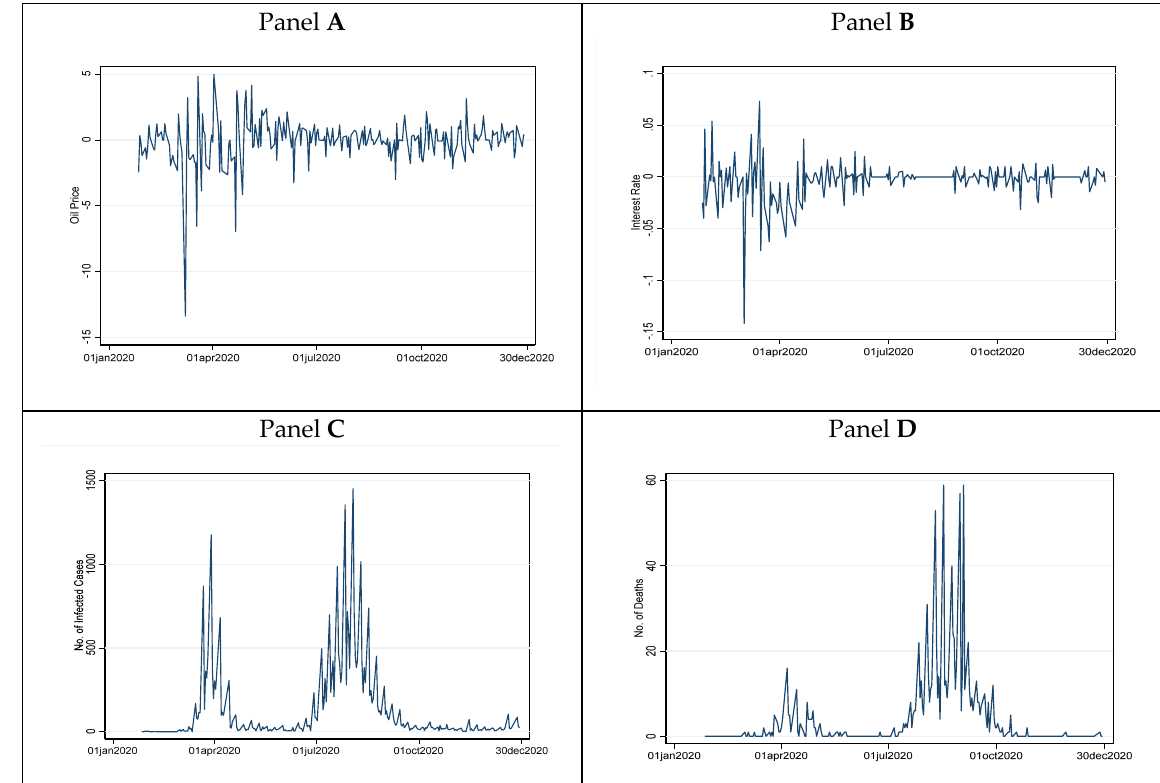
Figure 2. Panel ( A ) shows the first difference of Oil Price, Panel ( B ) depicts the first difference of Interest rates, Panel ( C ) presents the first difference of the number of confirmed cases from COVID-19, while Panel ( D ) is the first difference of the number of deaths due to COVID-19. We use data of 197 stocks listed on S&P/ASX200 from 27 January 2020 to 30 December 2020 to examine the effect of COVID-19 on Australian stock returns and their volatility. VWR-ASX200 is the value-weighted return of 197 stocks listed in S&P/ASX200 at level, Oil Price is the international crude oil price to the order I(1), the Interest rate is Australian one-month interbank interest rate to the order I(1), COVID-19A represents the total number of confirmed cases in Australia due to COVID-19 to the order I(1), COVID-19B represents the total number of deaths in Australia due to COVID-19 to the order I(1) and COVID-19C is a dummy variable depicting the negative news, and it takes a value of 1 from 24 February 2020 to 22 March 2020 otherwise 0.